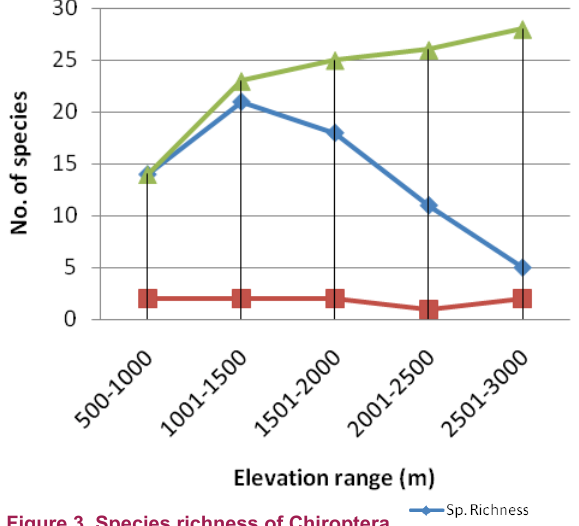
Figure 3. Species richness of Chiroptera along elevation gradients in Himachal